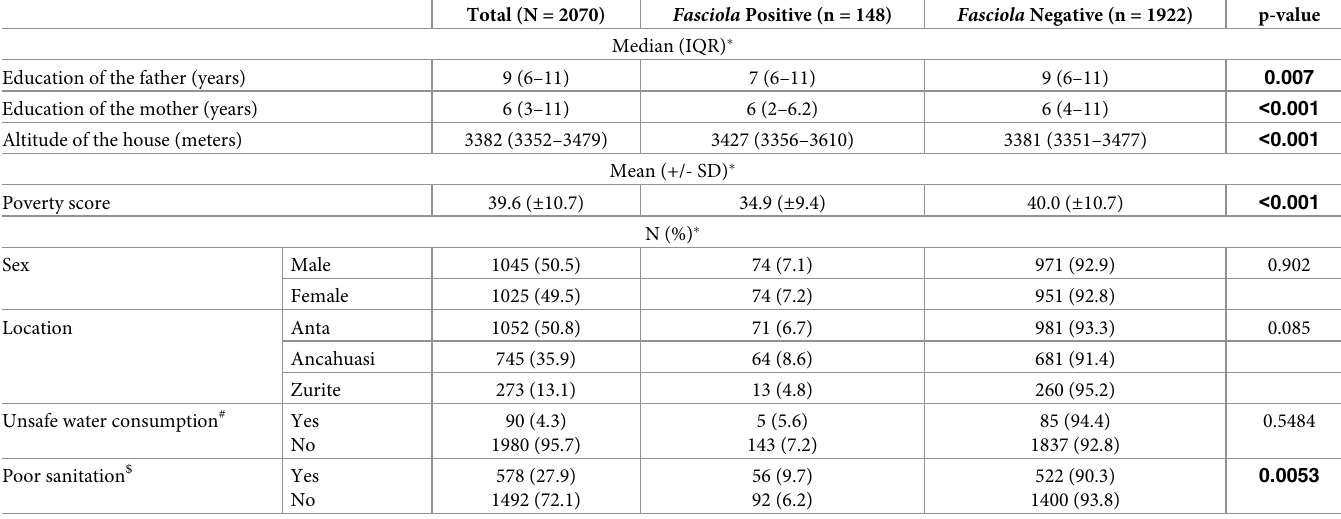
Table 1. Children demographic characteristics in Fasciola positive and negative